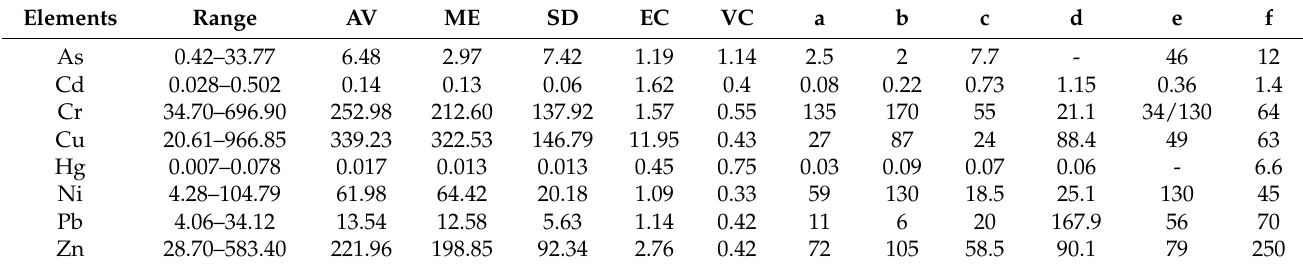
Table 5. Statistical characteristics of heavy metals in stream sediments of the Misiones province (ppm). Elements Range